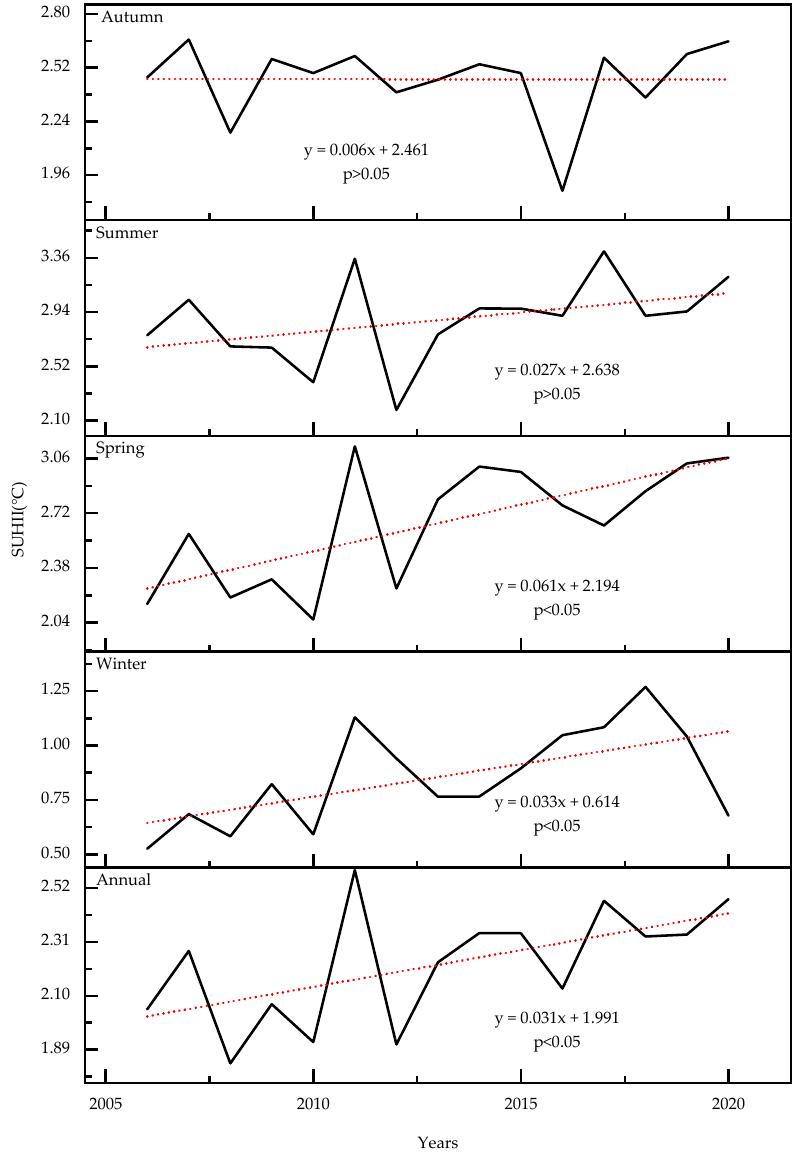
Figure 4. Trends for averaged daytime SUHII .